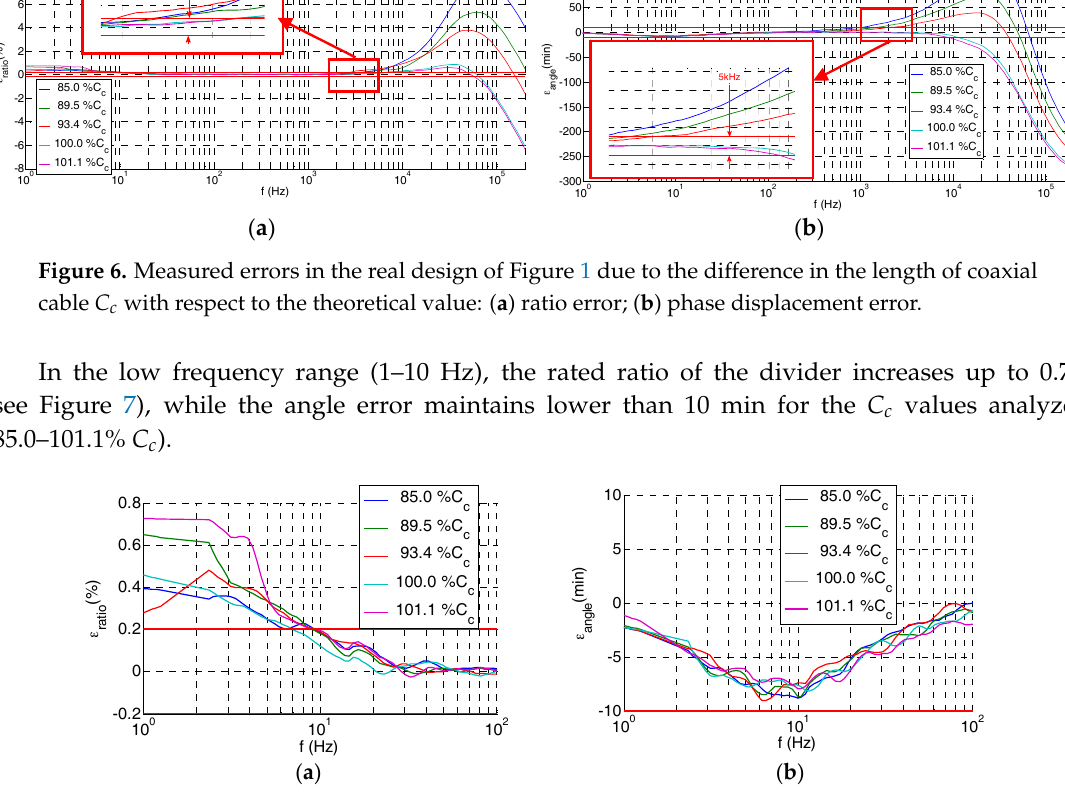
( b ) Figure 8. Frequency response curves: the red curve is obtained via Equation (9) and the blue curve was measured in the LCOE laboratory: ( a ) ratio error; ( b ) phase displacement error. 4. Improved Electrical Model To improve the simplified model shown in Figure 3a, the 2nd resistor of the HV branch is split into two parts, as is shown in the circuit of Figure 3d. Each resistance part k·R and (1 − k ) · R has a different stray capacitance C s ′′ and C s ′′′ in parallel depending on the geometrical location between the resistance and the central electrode (see Figure 2a), which it is considered in the PSPICE circuit shown in Figure 9 by C sp 1 ( C s ′′ ) and C sp 2 ( C s ′′′ ), respectively. For the built sensor, an equivalent capacitance of C s ′′ is in parallel with the first part of the resistance part k·R and another capacitance of C s ′′′ is in parallel with the other resistance part (1 − k ) · R . The values of the coefficient k (0.96) and of the capacitances C s ′′ (0.20 pF) and C s ′′′ (0.87 pF) have been determined by an iterative process by means of circuit analysis and synthesis using PSPICE modeling and MATLAB in order to fit the theoretical curve of the frequency response to the real one measured in the laboratory. Furthermore, two additional resistors ( R sp and R e 2 p ) that mainly represent leakage resistances of both capacitor blocks are also added to simulate in a better way the real behavior of the built divider. The R sp magnitude also includes any difference between the 1st and the 2nd HV resistances. The improved model achieves a good fitting to the measured frequency response (see Figure 10) for the set values of the parameters of Table 1, while the simplified model does not fit the high frequency range (Figure 8). The frequency response measured in the built divider with a small change in the emplacement of the 2nd resistance is also included in Figure 10. The emplacement change moved vertically 2 mm from the relative position of the 2nd resistance regarding the central electrode. A significant influence in the frequency response curve can be observed, which justifies the inclusion of stray capacitances C s ′′ and C s ′′′ in the improved circuit model shown in Figure 3d and in its simulate PSPICE circuit shown in Figure 9.